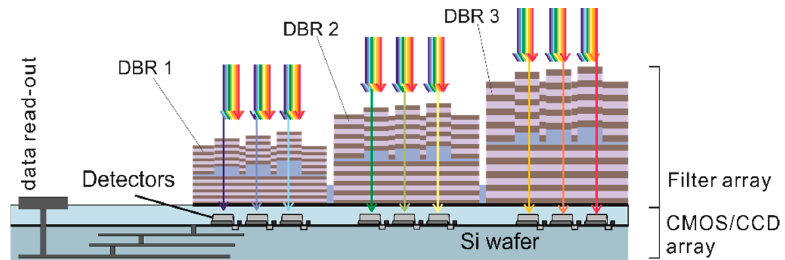
Figure 3. Schematic of a nanospectrometer consisting of an FP filter array with three different dis- tributed Bragg reflectors (DBRs) of different central wavelengths in combination with a sensor array in complementary metal oxide semiconductor (CMOS) or charge-coupled device (CCD)